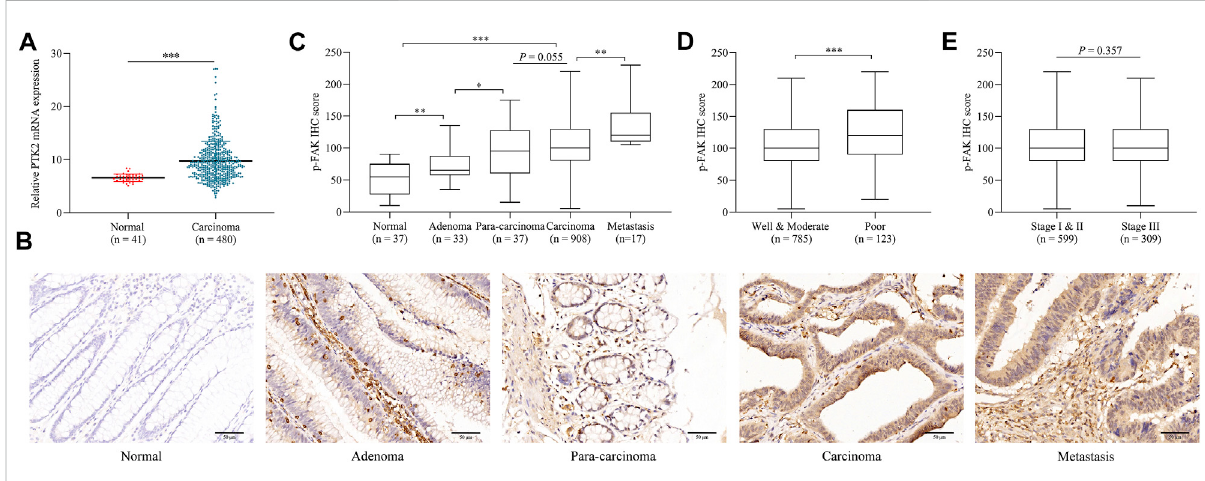
FIGURE 1 p-FAK expression in CRC. (A) Bioinformatics analyses of PTK2 mRNA expression in normal tissue and CRC. (B) Representative images of IHC. Scalebar,50 μ m. (C) Comparison ofIHCH-scoreamongdifferentcolorectalpathologicaltissues. (D) ComparisonofIHCH-scorebetweendifferent differentiation grades. (E) Comparison of IHC H-score between different TNM stages. The error bar represents the mean ± SD. * p < 0.05, ** p < 0.01, *** p <